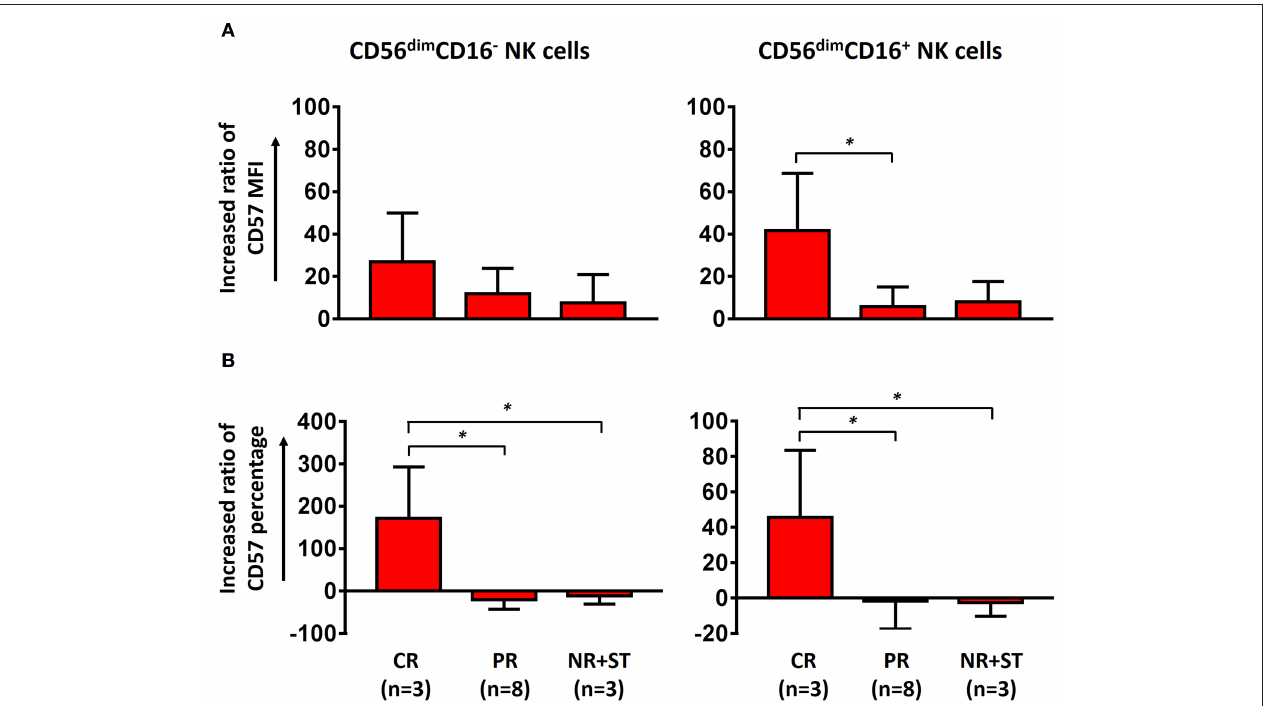
FIGURE 3 | Effect of ECP on maturation of CD56 dim NK cells. Both the MFI of CD57 on CD56 dim NK cells (A) and the frequency of CD57 + CD56 dim NK cells (B) were upregulated in aGVHD patients with CR ( n = 3, excluding patient #8 due to the limited cell number of sample) but not in patients with PR ( n = 8) and NR + ST ( n = 3, excluding patient #5 due to the limited cell number of sample) after ECP treatment. The increasing ratio of the percentage was been calculated as followed: [(percentage of T2 – percentage of T1) × 100]/percentage of T1. The increasing ratio of the MFI was calculated as followed: [(MFI of T2 – MFI of T1) × 100]/MFI of T1. * p <